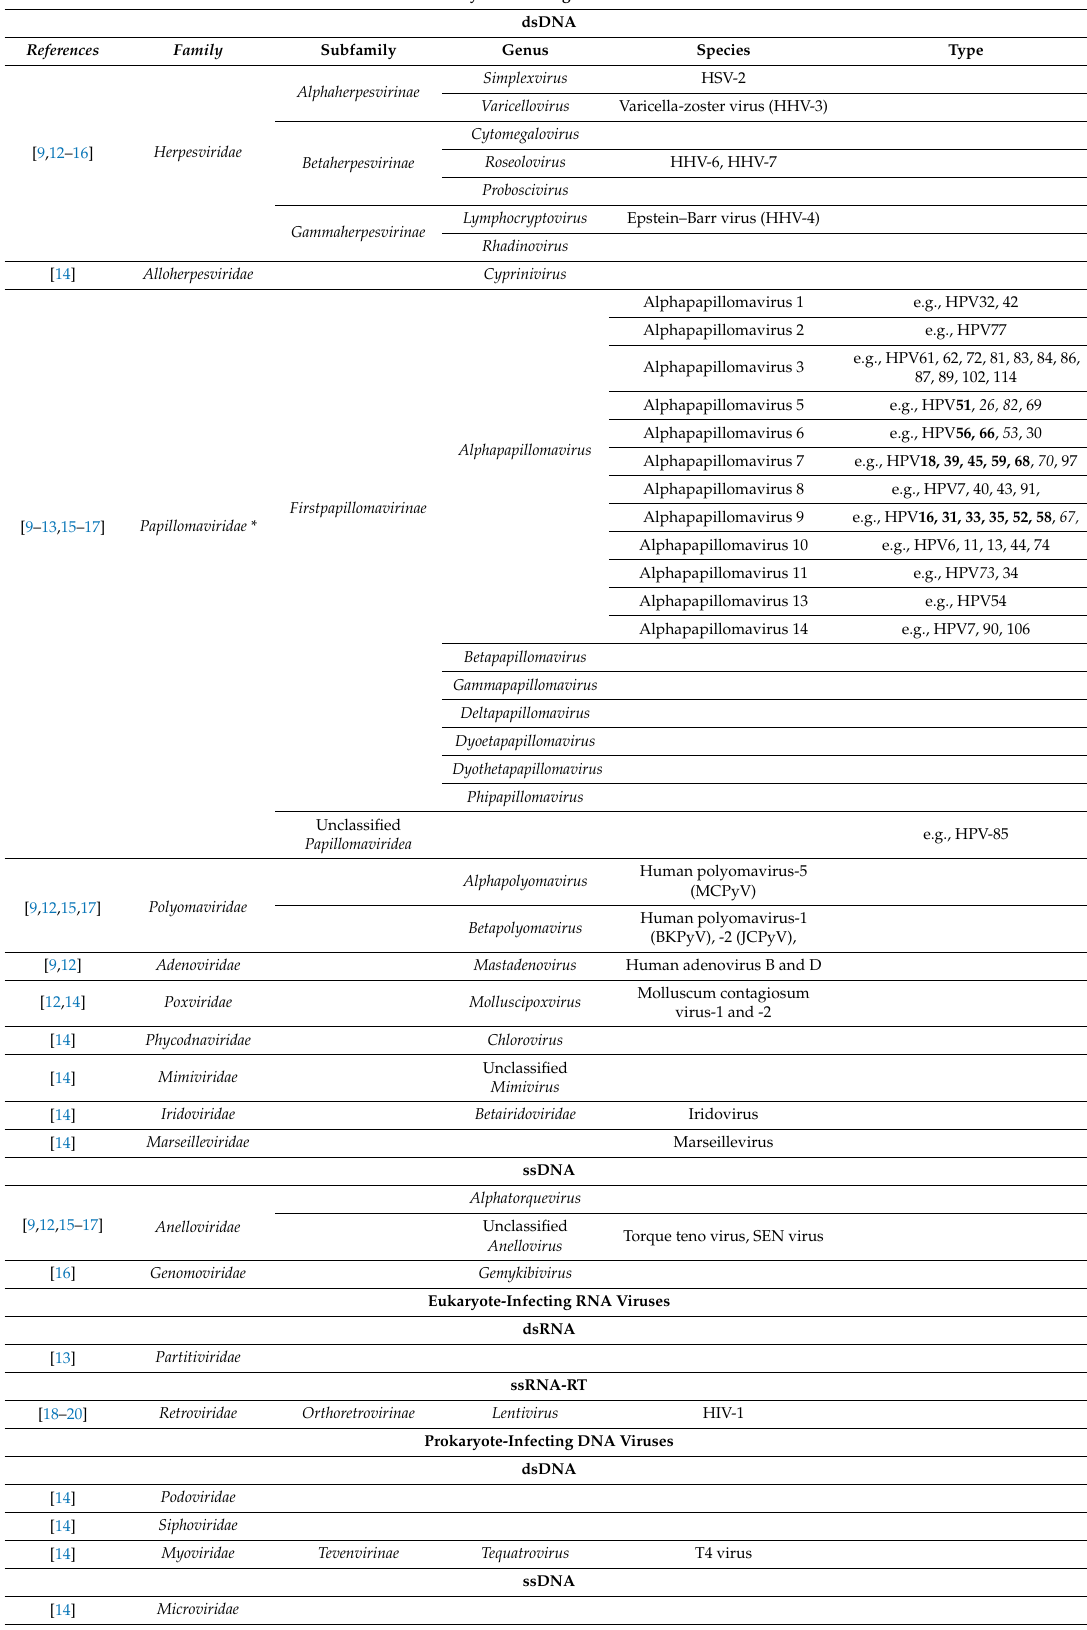
Table 1. Described viruses found in the female genital